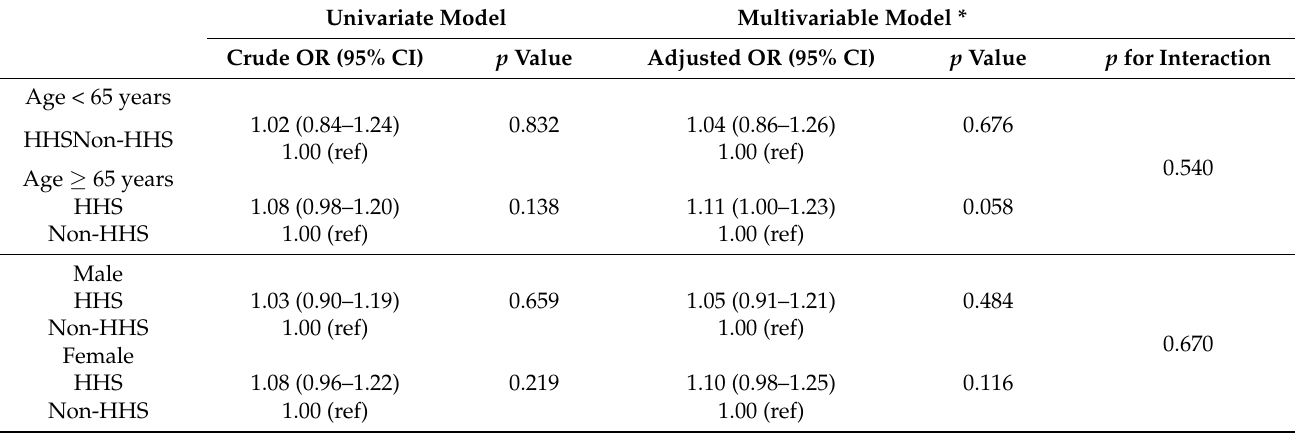
* The multivariable logistic regression model adjusting for all baseline characteristics shown in Table 1. Ab- breviations: HHS = hyperosmolar hyperglycemic state; OR = odds ratio; VTE = venous thromboembolism; CI = confidence interval; ref. =